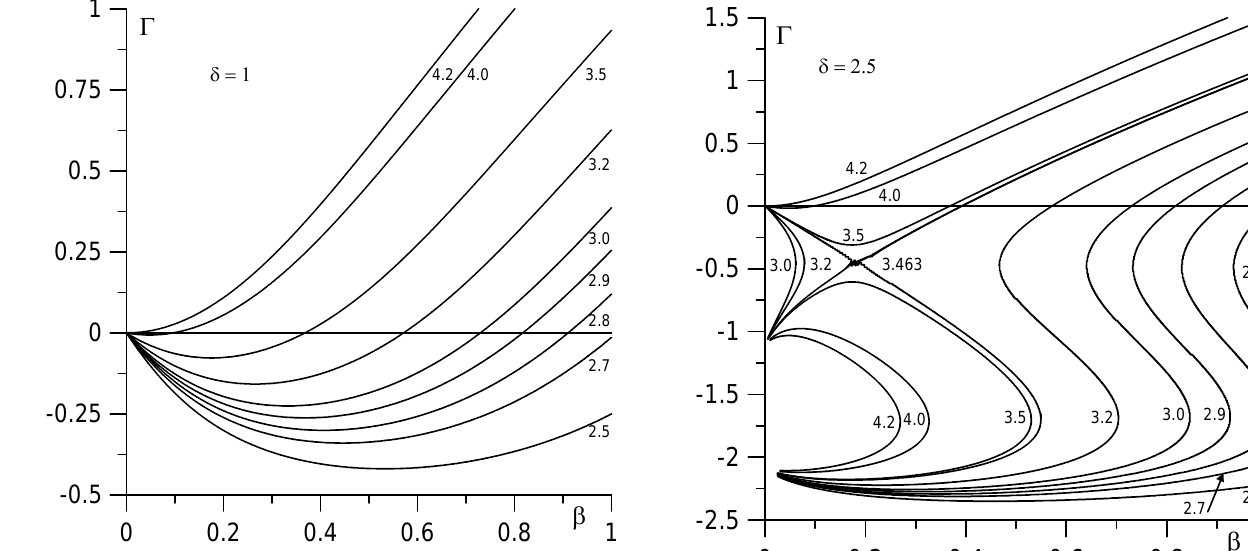
Figure 5a. Spectrum of flute modes for 01.0 =δ (local noon).